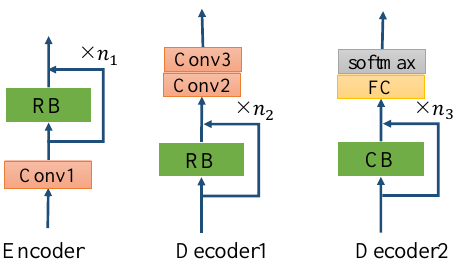
Figure 4. The structure of encoders and decoders. The orange boxes denote convolutional layers, where “Conv1” denotes a convolutional layer with a filter of 1 × 1 followed by a Leaky ReLU function, “Conv2” denotes a convolutional layer with a filter of 3 × 3 followed by a Leaky ReLU function, and “Conv3” denotes a convolutional layer with a filter of 1 × 1. The green boxes denote the regression block or the classification block in Section 3.1. The yellow box denotes the two fully connected layers. The gray box denotes the softmax layer. “ n *” denotes the stacked numbers of